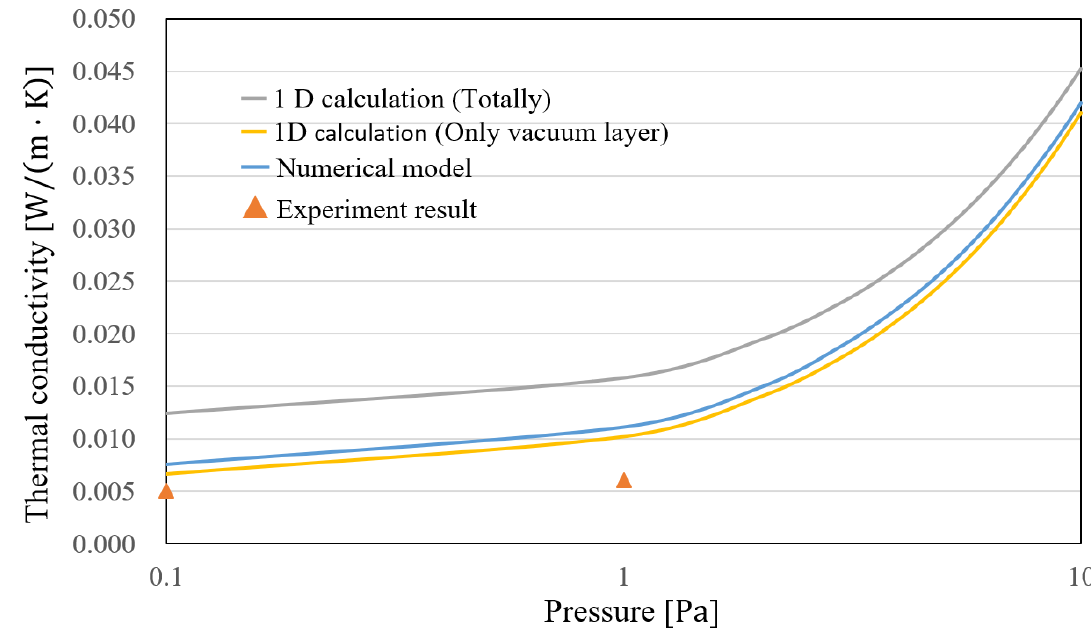
Figure 13. Comparison of the simulation and experimental results.